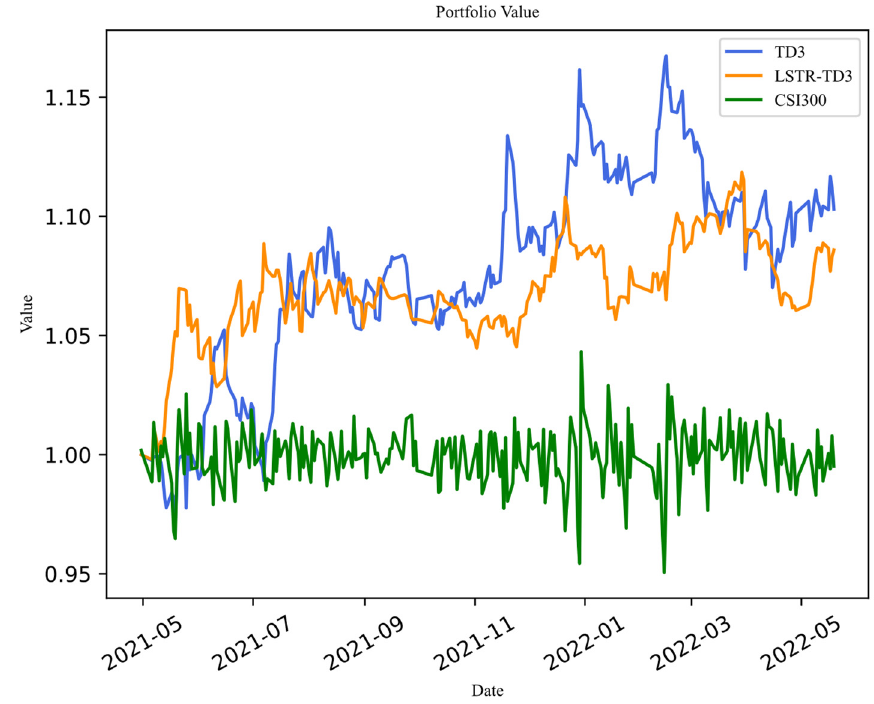
Figure 11. Portfolio value of Portfolio 2.